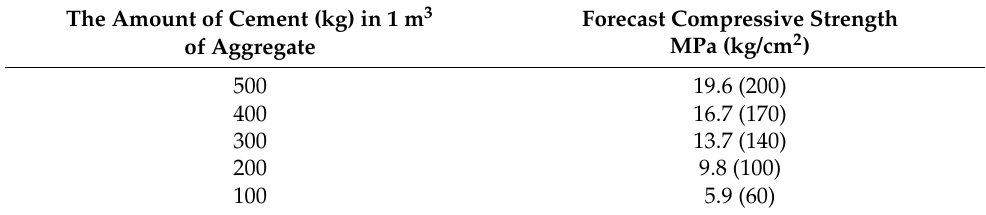
Table 2. Concrete strength depending on the amount of cement in 1 m 3 aggregate (according to guidelines given in [36]).